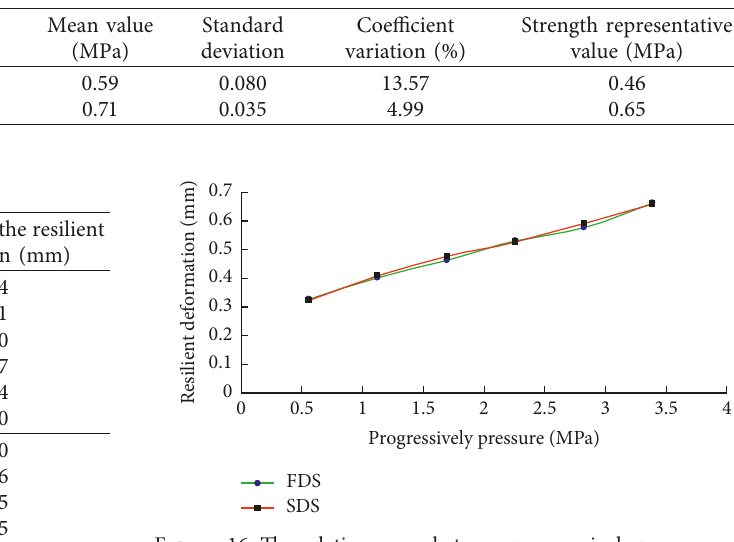
Table 10: The test results of STS.